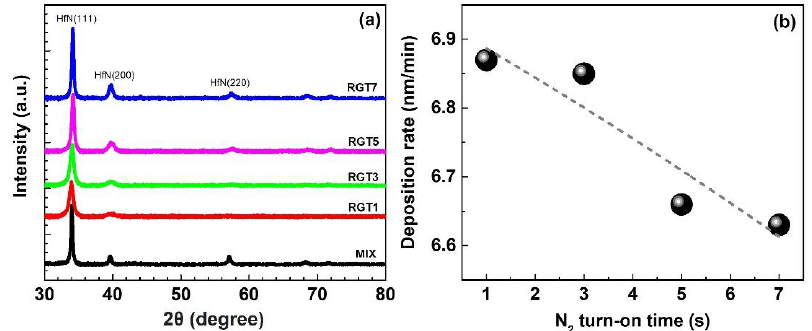
Figure 2. ( a ) XRD pattern of HfN thin films and ( b ) deposition rate of HfN thin films.